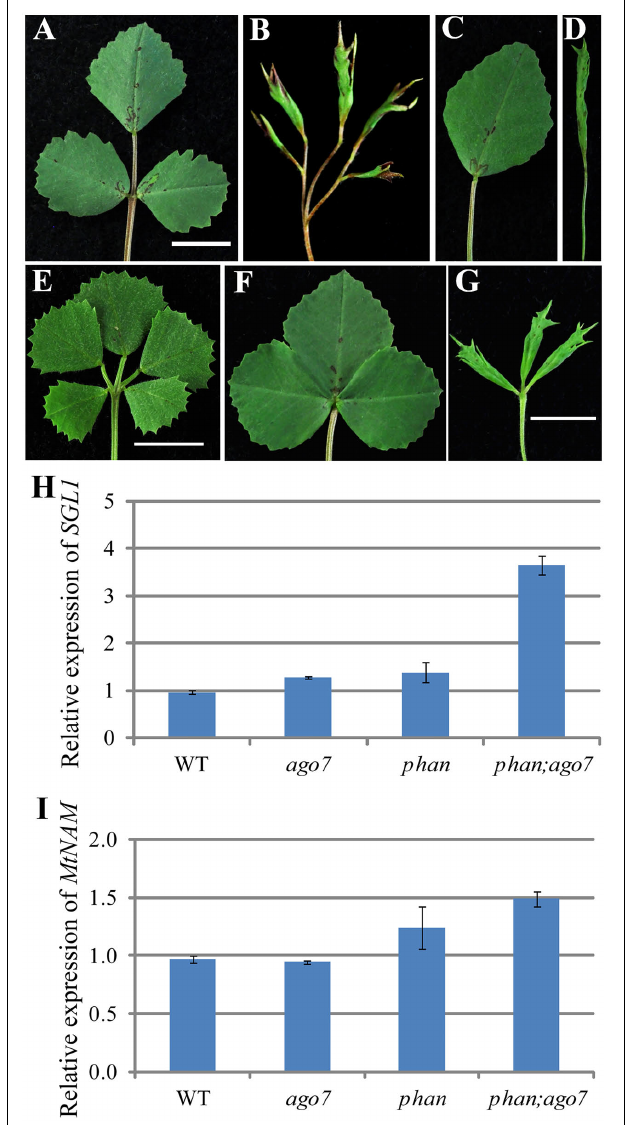
FIGURE 8 | SGL1 and NAM are required for the development of ectopic lateral leaflets in the mtphan;mtago7 double mutant. Images of mature leaves in WT (A) , mtphan;mtago7 (B) , sgl1 (C) , mtphan;mtago7;sgl1 (D) , palm1 (E) , mtnam (F) , and mtphan;mtago7;mtnam (G) . (E) Was the same as in Figure 5A . The mtphan;mtago7;sgl1 triple mutant develops simple leaves similarly as sgl1 , and the mtphan;mtago7;mtnam triple mutant develops trifoliate leaves with greatly reduced rachis, resembling leaf phenotype of the mtnam mutant. Quantitative RT-PCR analyses of transcript levels of SGL1 (H) and MtNAM (I) in WT, and mtago7 , mtphan, and mtphan;mtago7 mutants. Shown are means ± SD; n = 3.